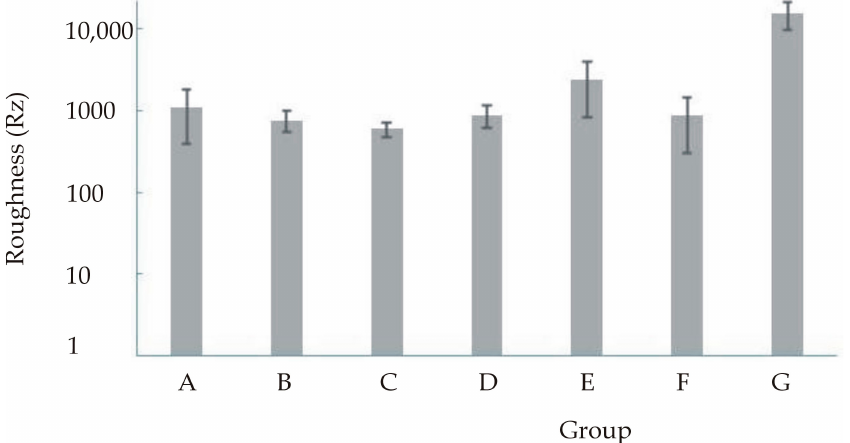
Figure 5. Mean value and standard deviation (logarithmised) for roughness (Rz).